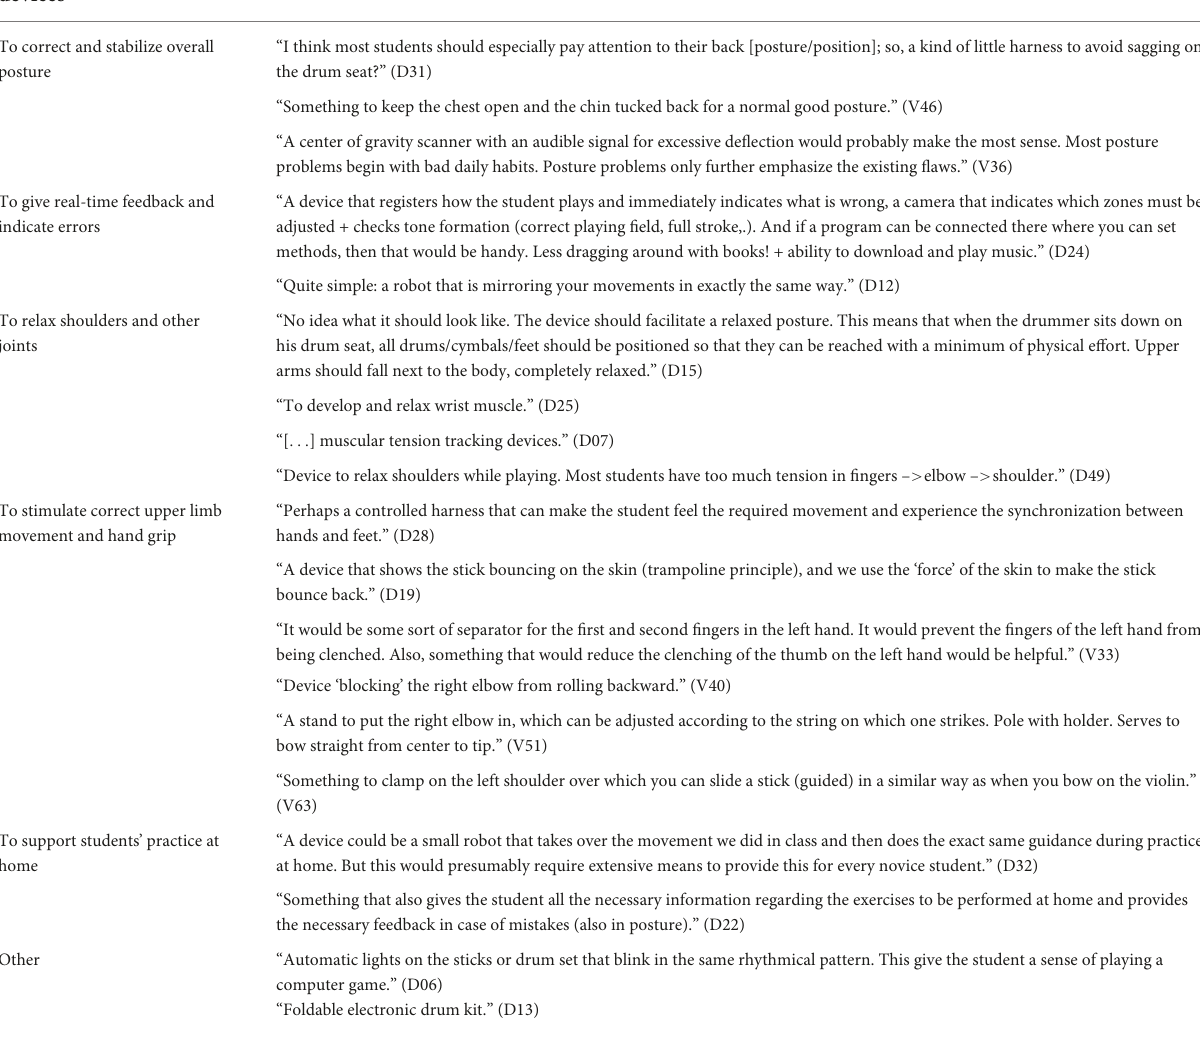
TABLE 3 Teachers’ design ideas for wearable devices.